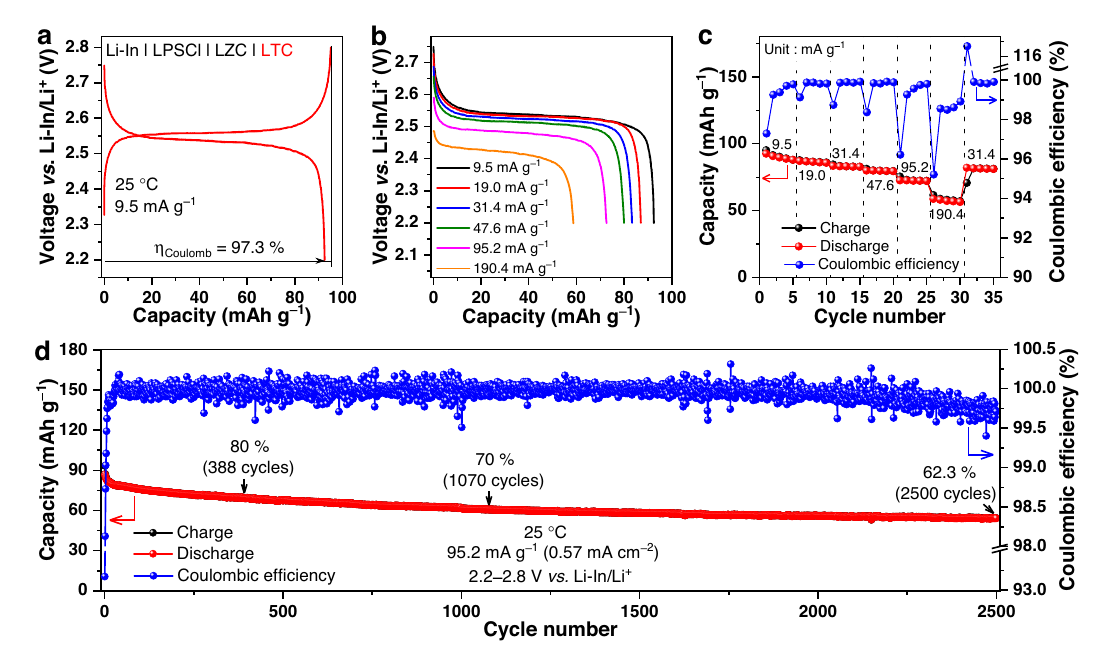
Fig.3|ElectrochemicalperformanceoftheLi-In|LPSCl|LZC|LTCcellbasedon the Ti 3+ /Ti 4+ redox couple. a The initial charge/discharge curves under 9.5mAg − 1 at 25°C. b , c Rate capability at 9.5, 19.0, 31.4, 47.6, 95.2, and 190.4mAg − 1 at 25°C.